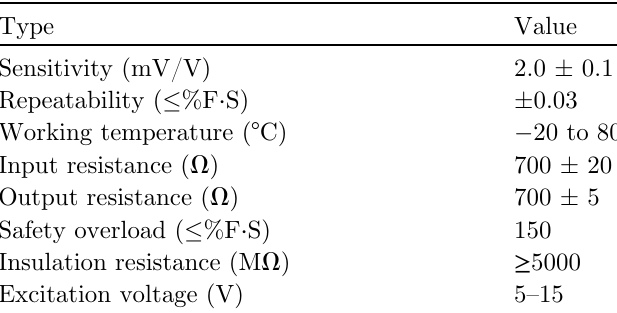
Table 1. Parameters of pressure sensor.